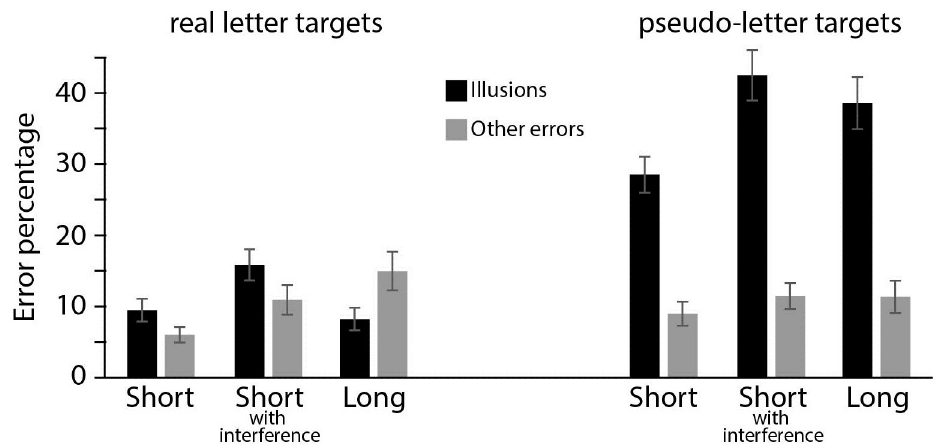
Fig 2. Experiment 1. Error rates in trials where participants indicated high confidence in their response. Percentages of expectation-induced errors and other errors are depicted for pseudo-letter targets (right display) or a real letter targets (left display). All error rates are reported for each of the three Memory Delay conditions.